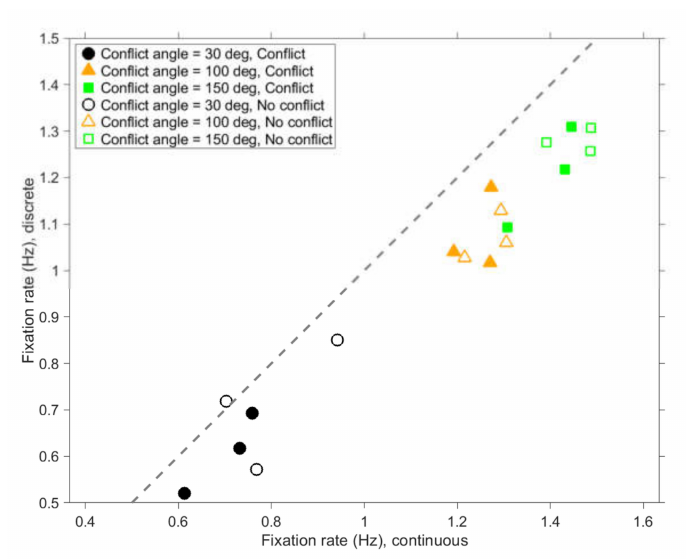
Figure 2. Mean number of fixations per second for scenarios with discrete stimuli versus scenarios with continuous stimuli. Each marker represents the average of 35 participants. The dashed line is the line of equality.